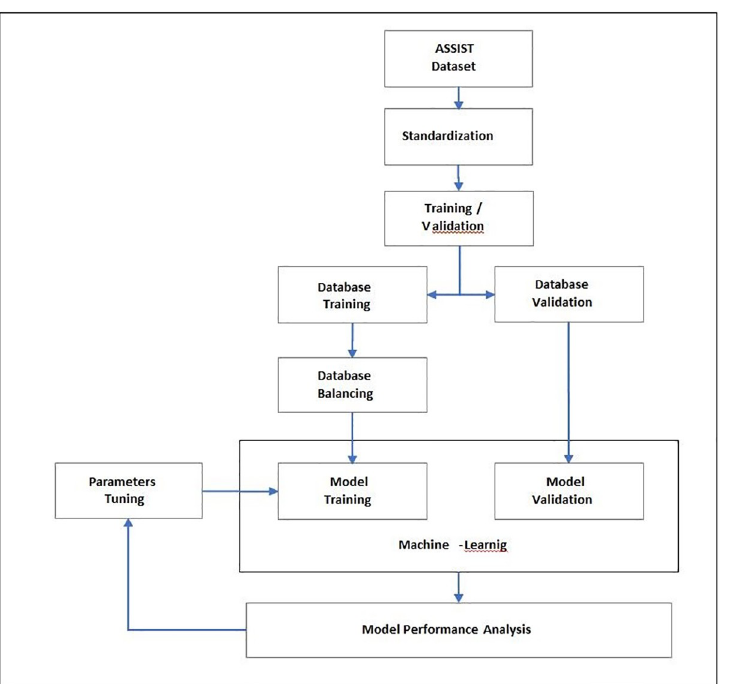
Fig 1. Steps performed in the model